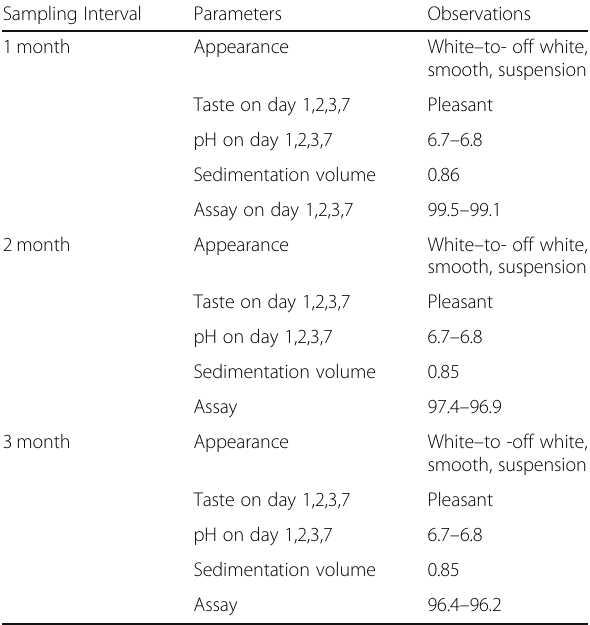
Table 6 Accelerated stability study of formulation